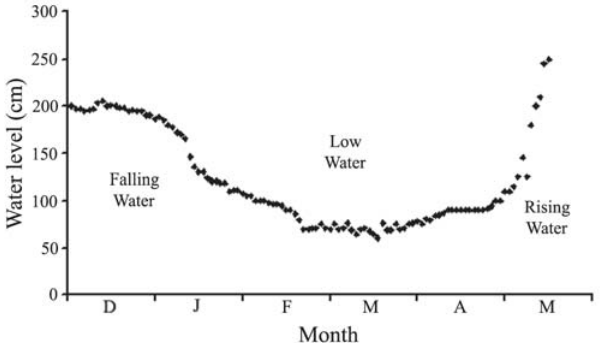
Fig. 3. Water level fluctuations of the Cinaruco River